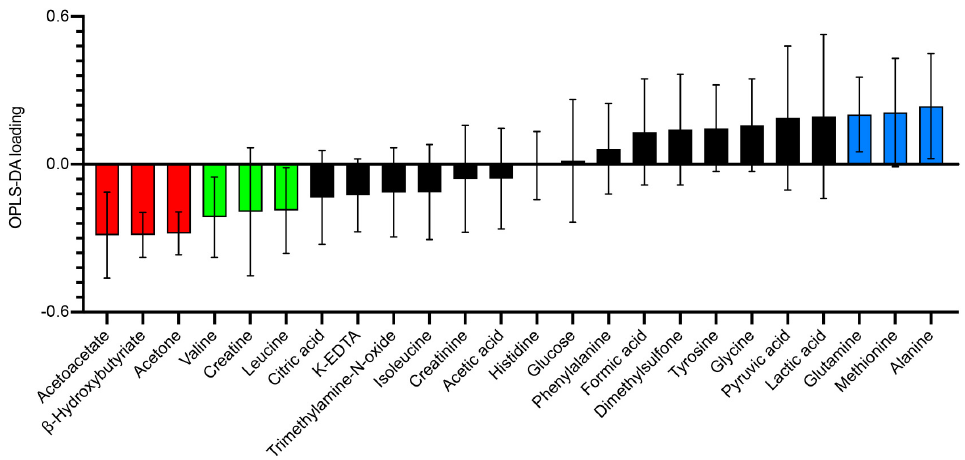
Figure 2. Loading plot of a one-component OPLS-DA model (R2X = 0.292, R2Y = 0.773, Q2 = 0.648) of baseline (HCD-HFD vs. HFD-HCD) metabolite values in normal-weight, healthy subjects on the day of the mixed meal test (MMT) after two weeks of HFD vs. HCD in a cross-over study design. Each individual was their own cross-validation subject. A total of 999 permutations returned R2 and Q2 intercepts at 0.181 and − 0.279, respectively, meaning that the model is robust. Error bars indicate jack knife standard error of the loading computed from all rounds of cross-validation. The more a metabolite loading differs from 0, the more it influences the model. Corresponding data (HFD and HCD) cluster nicely in this PCA (principal component analysis) model without outliers in Hotelling’s T2 or DmodX (not shown). Metabolites classified as good (almost all individuals with a signal correlation value above 95%) from the Bruker IVDr analysis were used.